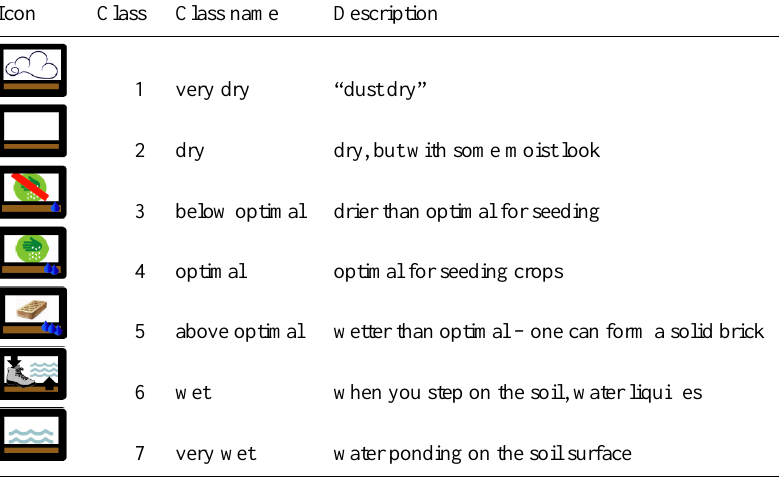
Table 1. Soil wetness classification scheme (Swahili version see Supplement) with the seven wetness classes based on qualitative indicators related to best conditions for seeding and brick making. Icon Class Class name Description 1 very dry “dust dry” 2 dry dry, but with some moist look 3 below optimal drier than optimal for seeding 4 optimal optimal for seeding crops 5 above optimal wetter than optimal – one can form a solid brick 6 wet when you step on the soil, water liquifies 7 very